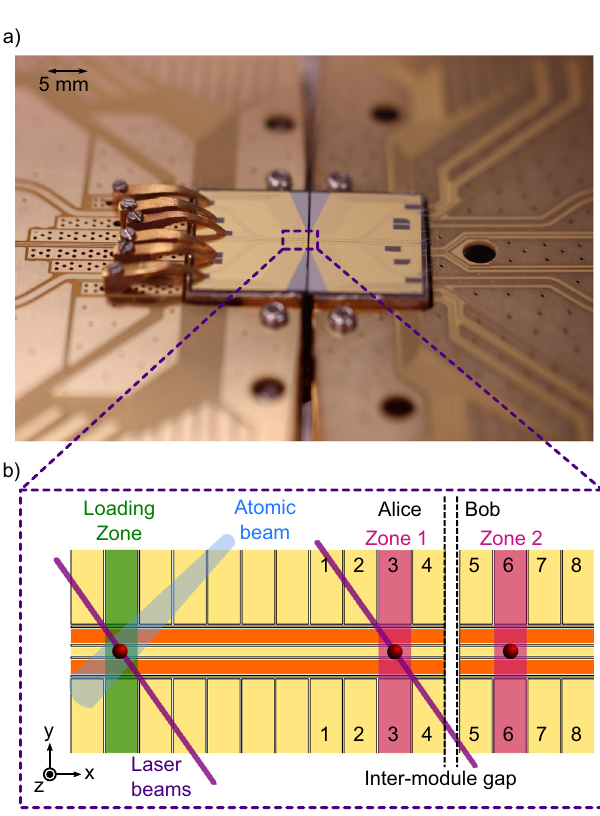
Fig. 2 | An illustration of a small section of a modular version of the QCCD quantum computer architecture. a ) Two modules ("Module A" and “ Module B") are shown as fully opaque and parts of ten other modules are shown as partially transparent. As an example, each module contains 4 X-junctions and is structured suchthatittessellates withneighbouringmodules.Arealisticimplementationmay featuremanymoreX-junctions permodule. Inset b )showsa single X-junctionona module. For this architecture, speci fi c areas of the X-junction are associated with